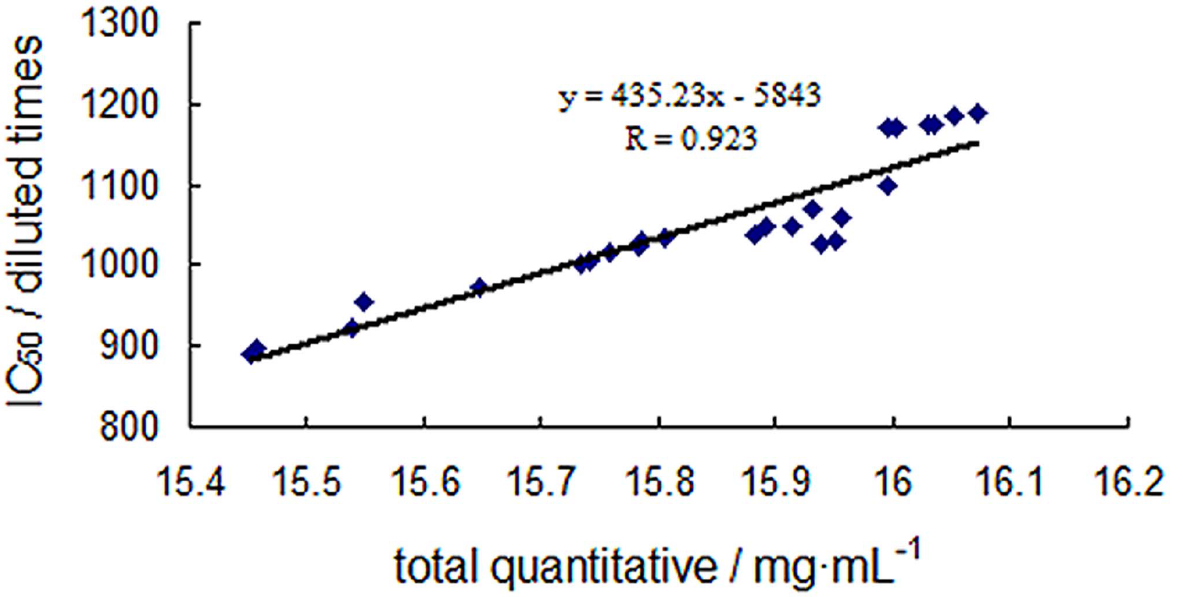
Figure 6. Relationship of the total quantitative and antioxidant activity of Reduning injection.